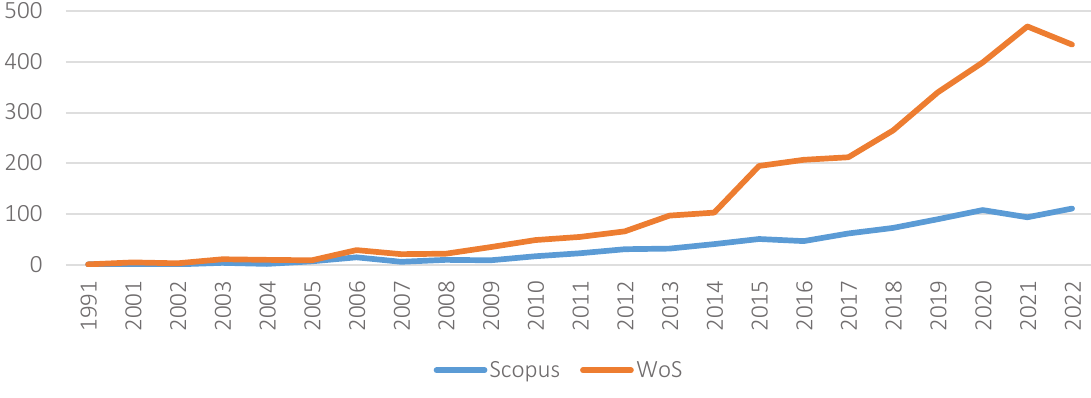
Figure 1. Dynamics of published articles for 1991–2022 for the search query “sustainability reporting AND accounting”, the number of articles